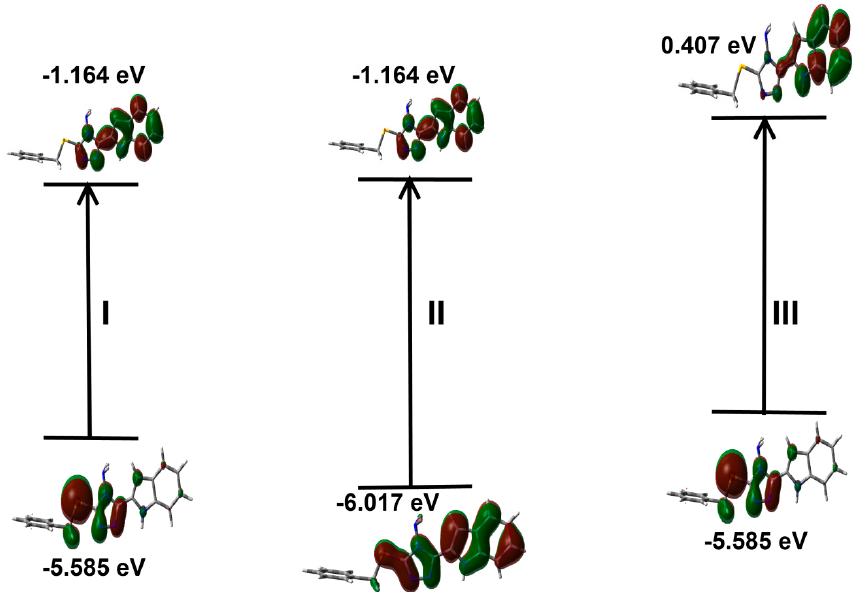
Figure 10. Presentation of the molecular orbitals included in the electronic transitions of 2 in ethanol as solvent. The definition of I , II and III refer to Table 5.